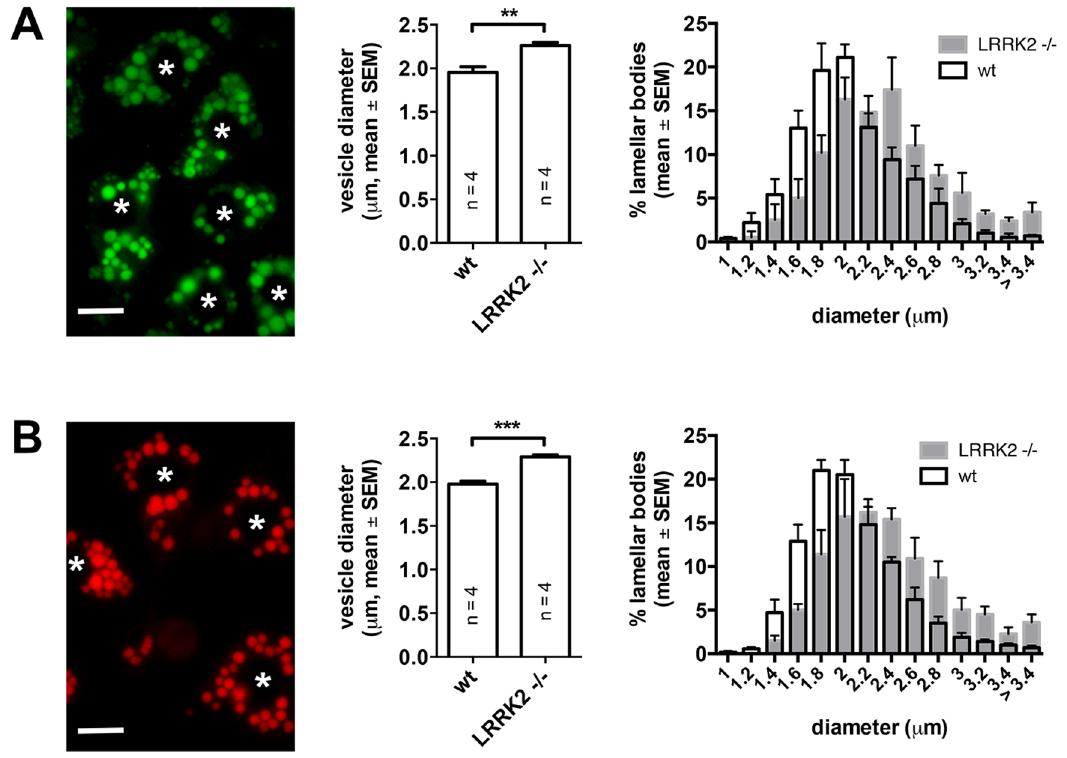
Figure 1. LBs are significantly enlarged in LRRK2 -/- rats. (A) LBs (green) in cells that were metabolically labeled with Bodipy phosphatidylcholine (left, asterisks indicate nuclei, scale bar =10 m m). LB size was significantly (p , 0.006) increased in cells from LRRK2 -/- animals (diameter: 2.26 m m 6 0.04, n=4 animals) compared to LBs in cells from wt animals (diameter: 1.95 m m 6 0.07, n=4 animals) (middle). Size distribution diagram for LB sizes derived from wt and LRRK2 -/- animals (right, n=4 animals). (B) LBs (red) in cells that were stained with lipophilic dye Nile red (left, asterisks indicate nuclei, scale bar =10 m m). LB size was significantly (p , 0.0003) increased in cells from LRRK2 -/- animals (diameter: 2.29 m m 6 0.03, n=4 animals) compared to LBs in cells from wt animals (diameter: 1.98 m m 6 0.03, n=4 animals) (middle). Size distribution diagram for LB sizes derived from wt and LRRK2 -/- animals (right, n=4 animals). In all experiments 25 cells were analyzed in each animal corresponding to approx. 350 – 450 LBs per animal. Images were taken from LRRK2 –/-